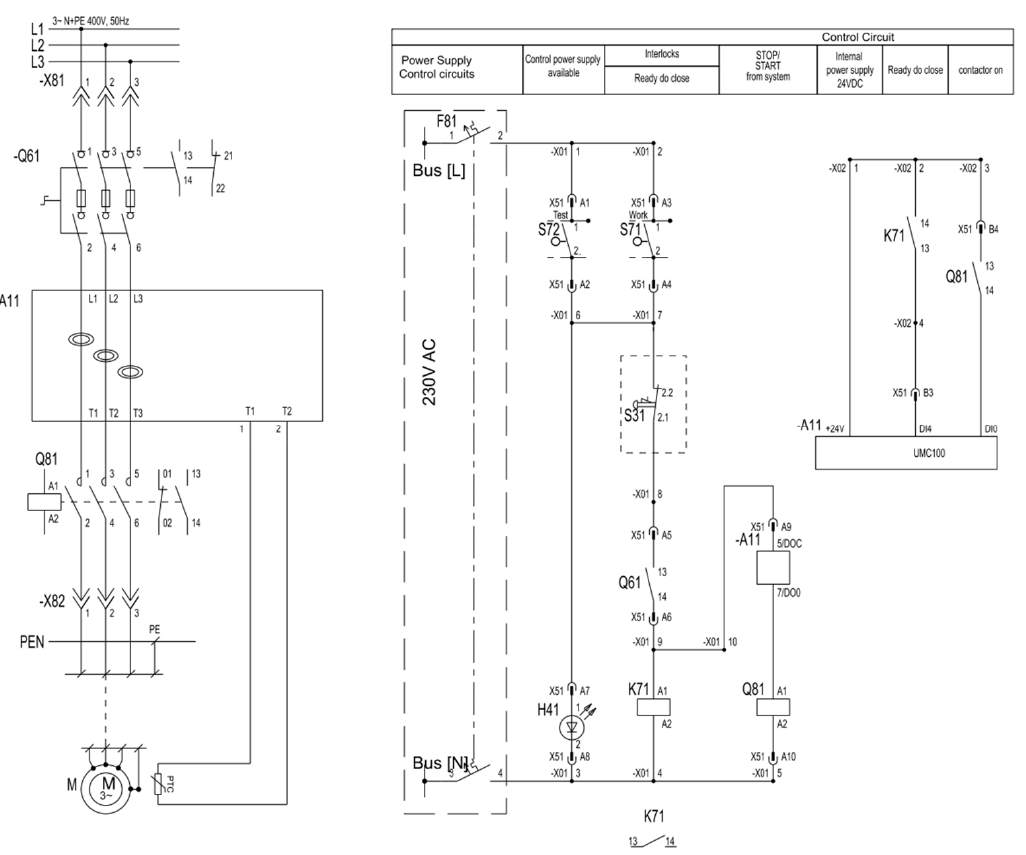
Figure 8. Power supply and control system with the use of a PLC controller with thermal protection.